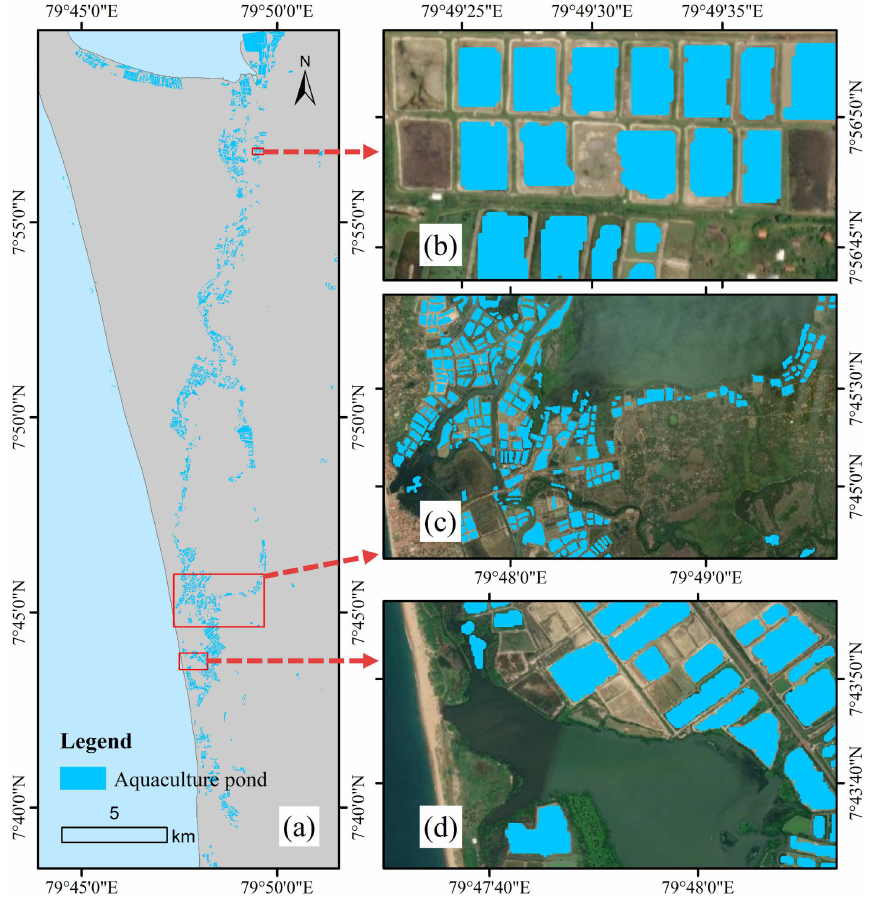
Figure 8. Extraction result of SOAPs in the study region: ( a ) a comprehensive overview of the distribution of aquaculture ponds in the study region; ( b ) the similar shapes and sizes of SOAPs extracted in this study compared to the ground-truth data; ( c ) most extracted aquaculture ponds were separated from adjacent waters and extracted as SOAPs; ( d ) abandoned ponds excluded from the extraction